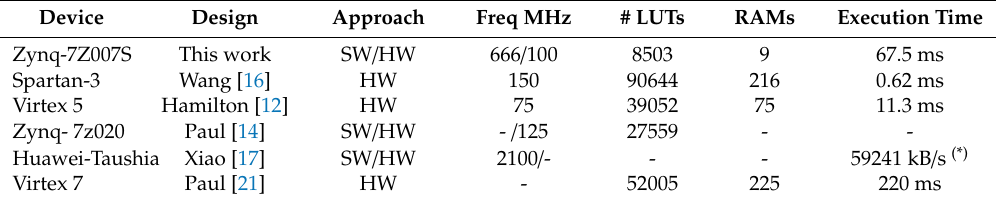
Table 5. TLSv1.2 implementation performance comparisons to recent